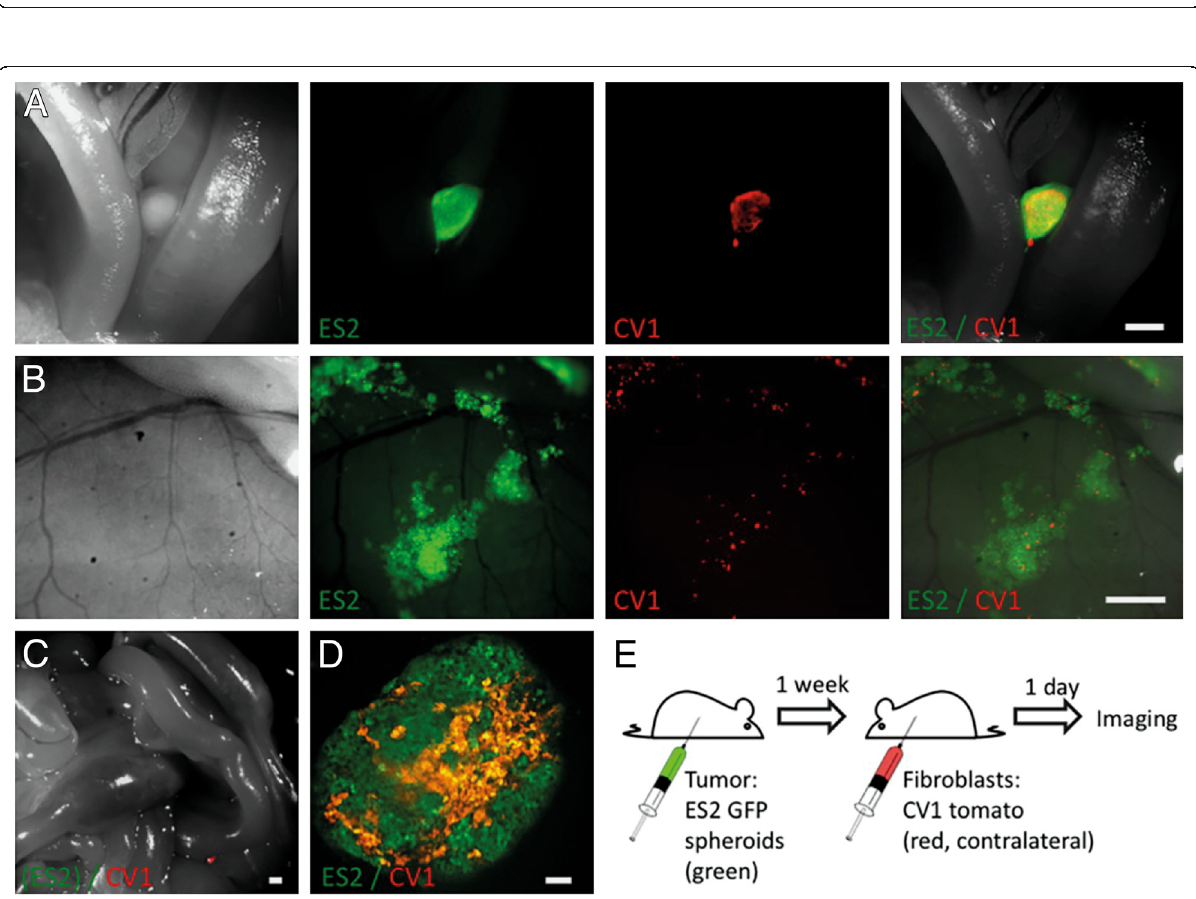
Fig. 4 Fluorescence imaging of a mouse showing fibroblast (red) migration from injection site to location of tumour cells (green). ( a ) Fibroblast recruitment to tumour injection site next to intensine. ( b ) Fibroblast recruitment to tumour patches attached to the peritoneal wall. ( c ) Fibroblast scattered in the abdomen of a control mouse without tumour injection. ( d ) High resolution image of fibroblasts recruited to a tumour. ( e ) experimental design (green)